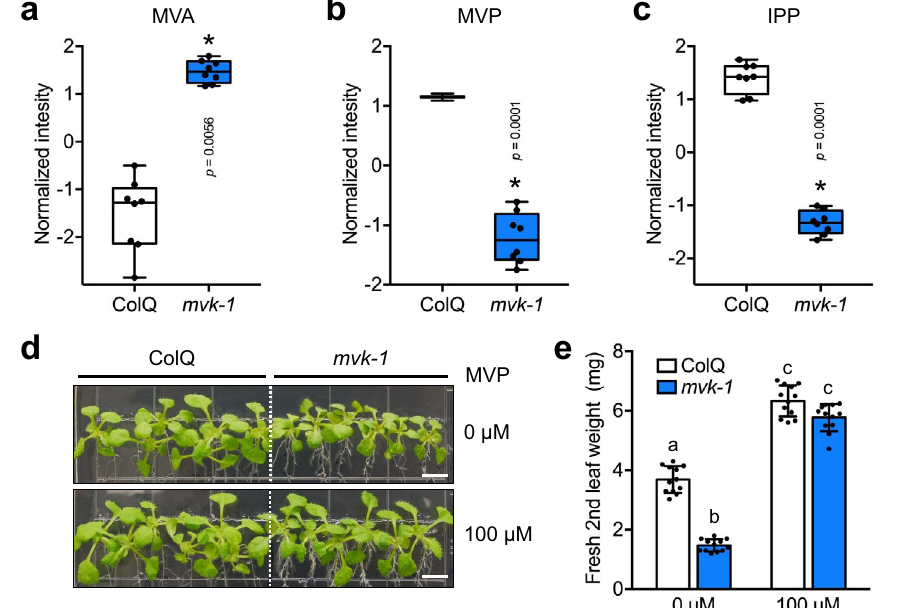
Fig. 3 mvk-1 mutant plants show reduced mevalonic acid-5-phosphate (MVP) levels. Exogenous application of MVP partially restores the altered mvk-1 mutant phenotype. a – c Box-and-whisker plots of intermediate compounds in MVA pathway showing their relative abundances. ColQ and mvk-1 mutant root extracts were analyzed with a high-resolution mass spectrometer (HRMS) Orbitrap Velos (Thermo Fisher Scienti fi c) coupled to a Thermo Vanquish HPLC (High Pressure Liquid Chromatographer; Thermo Fisher Scienti fi c). MVA, Mevalonic acid; MVP, Mevalonic acid-5-phosphate; IPP, isopentenyl diphosphate. Asterisks indicate signi fi cant differences between ColQ and mvk-1 (means ± SEM, n = 8 biological replicates, * P < 0.05, two-sided Student ’ s t test). Box-and-whisker plots show max and min, 25 – 75th percentiles (box), and median (center line). Experiment was repeated three times with similar results. d 16-day-old ColQ and mvk-1 mutant seedlings grown on medium without or with 100 µ M mevalonic acid-5-phosphate (MVP). Scale bars: 0.5 cm. e Fresh second leaf weight of 16-day-old plants ( n = 21 leaves for ColQ and n = 24 leaves for mvk-1 ). Data represent mean ± SEM from independent experiments. Means with different letters are signi fi cantly different ( P < 0.05). P values indicate signi fi cance relative to ColQ with mock treatment and were determined by one-sided ANOVA with multiple comparisons and adjusted using a Duncan post hoc test. Experiment was repeated three times with similar